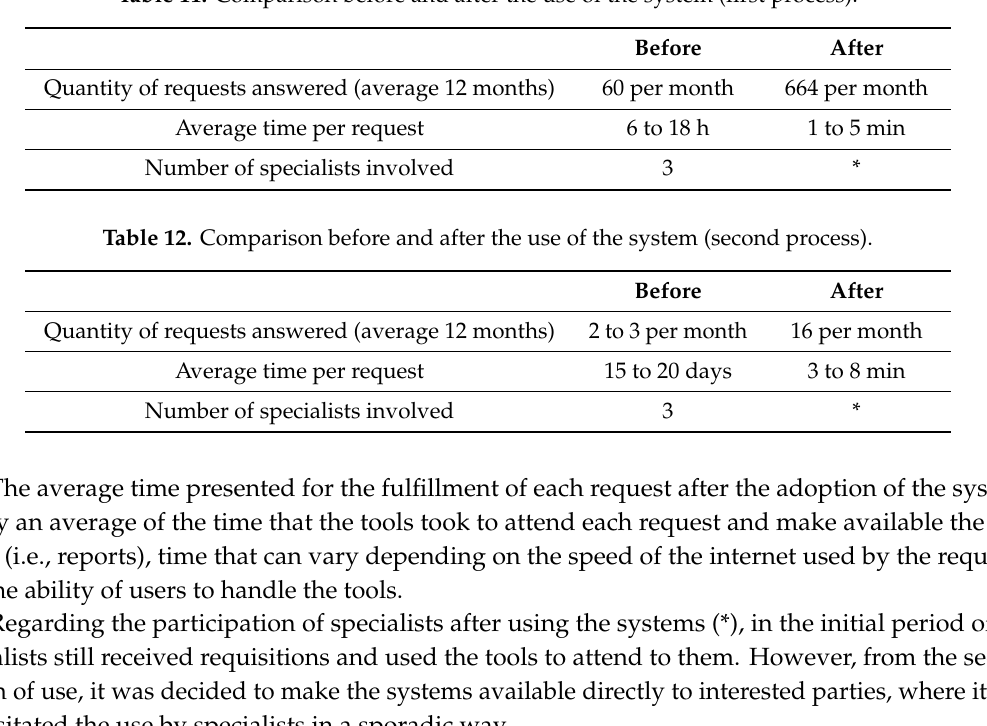
Table 11. Comparison before and after the use of the system (first process).